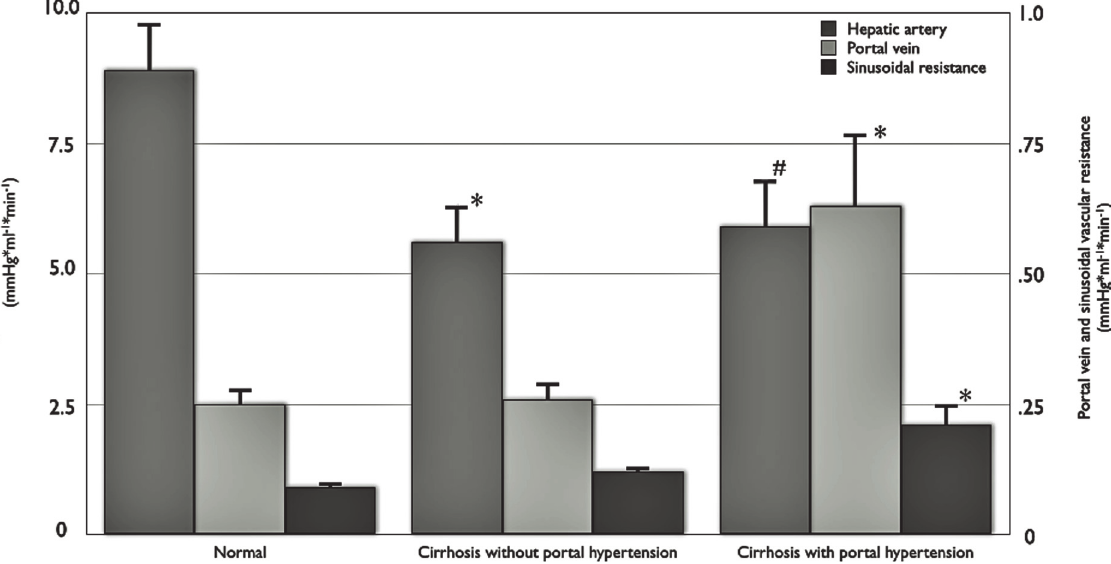
Fig 1. Basal vascular resistances of hepatic artery, portal vein and sinusoidal area in normal (n = 10) and cirrhotic rats with (n = 7) and without elevated portal resistance (n = 6; * p (cid:1) 0.02 compared to normal; # p = 0.08 compared to normal). Note the ten-fold difference in the scale of the hepatic arterial vascular resistance (left side) and the portal vein/sinusoidal vascular resistance (right